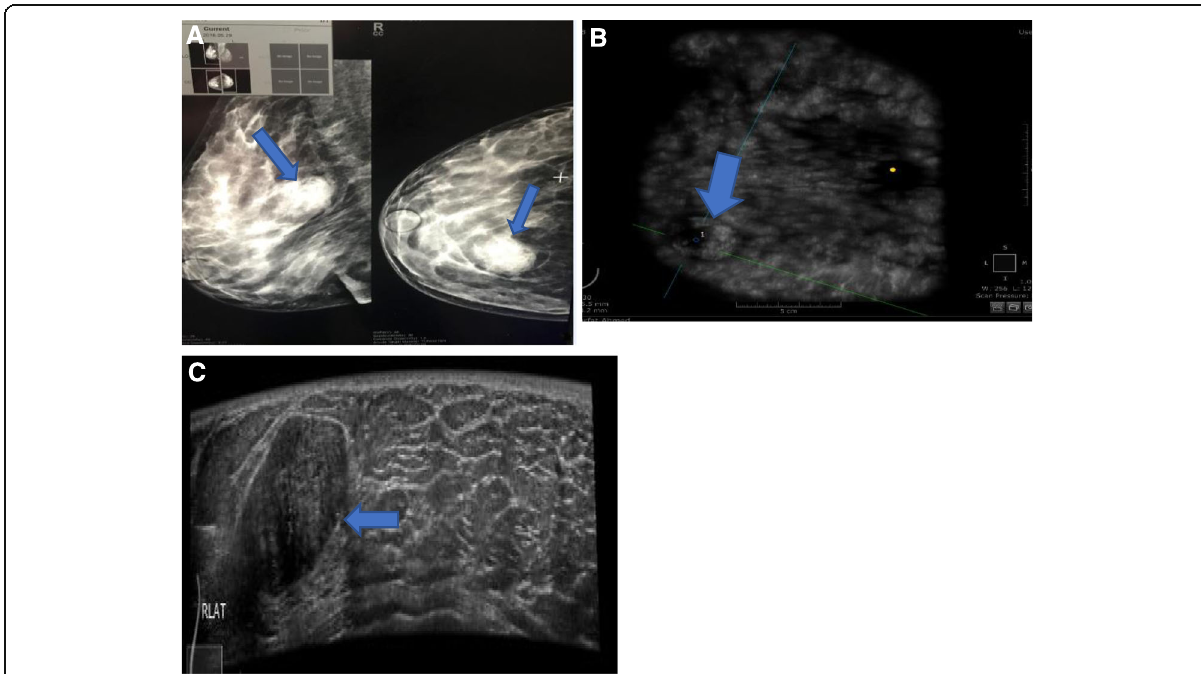
Fig. 2 a Mammogram shows an ovoid opacity at right breast 10 ’ clock position. b , c Lesions proved by ABUS to be a solid ovoid lesion